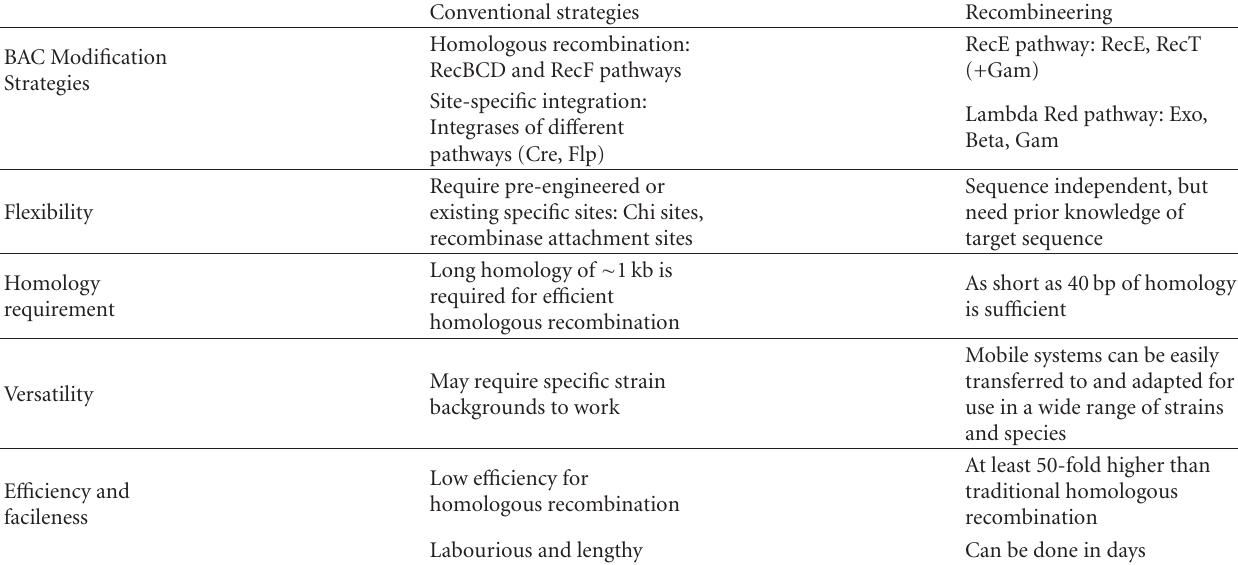
Table 1: Comparing conventional BAC modification strategies with